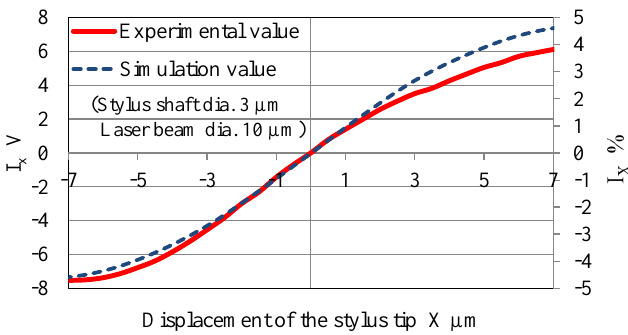
Figure 15. Simulation and experimental results for I X for a distance of L 1 = 40 mm ( X displacement of the stylus tip).